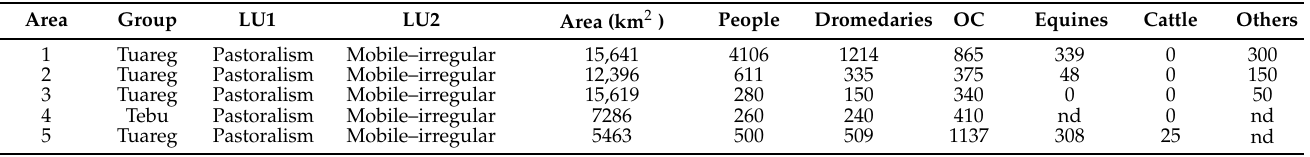
Table 1. Demographic, land use and livestock data in the areas of the Fazzan in the 1930s [35–37]. For the location of the areas, see Figure 4. LU1 = Land Use level 1; LU2 = Land Use level 2; OC = ovicaprines; Equines = horses and donkeys.